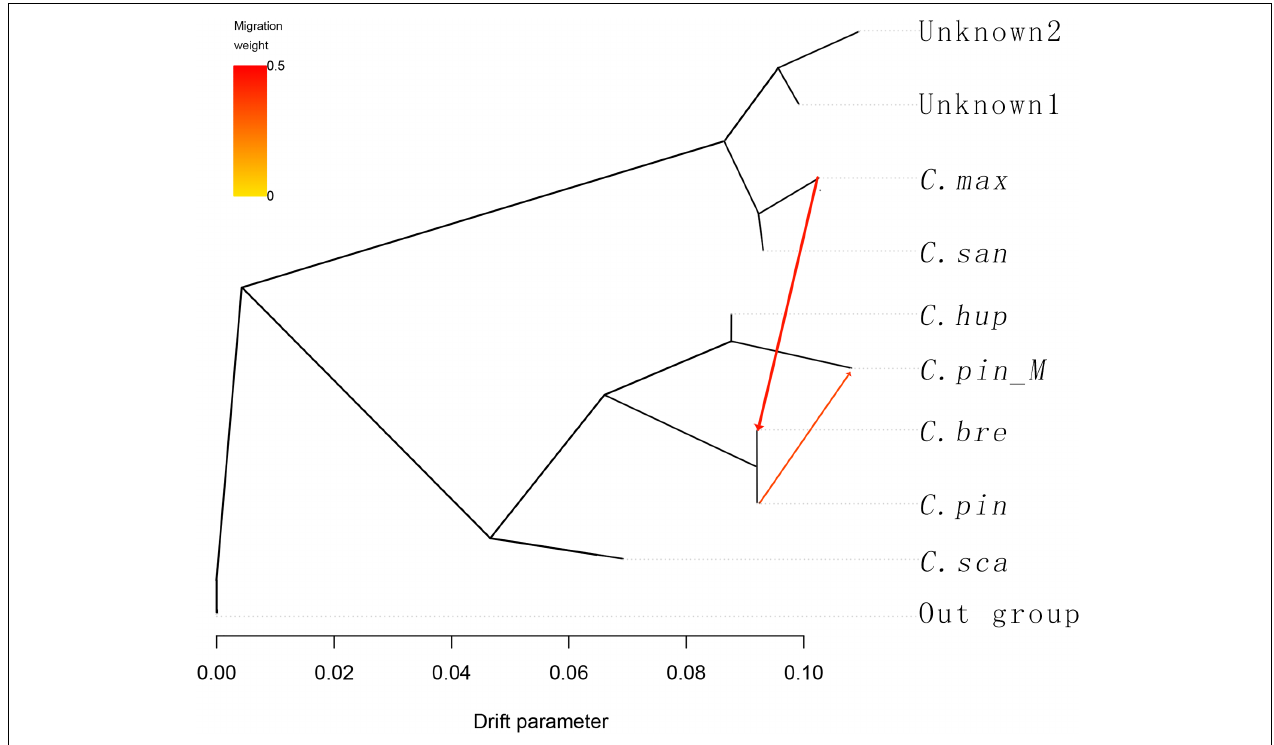
FIGURE 3 | TreeMix analysis of 53 hawthorn samples divided into 9 groups. With C. cruss-galli , C. monogyna and C. laevigata serving as the outgroup population, the arrow corresponds to the direction of migration.